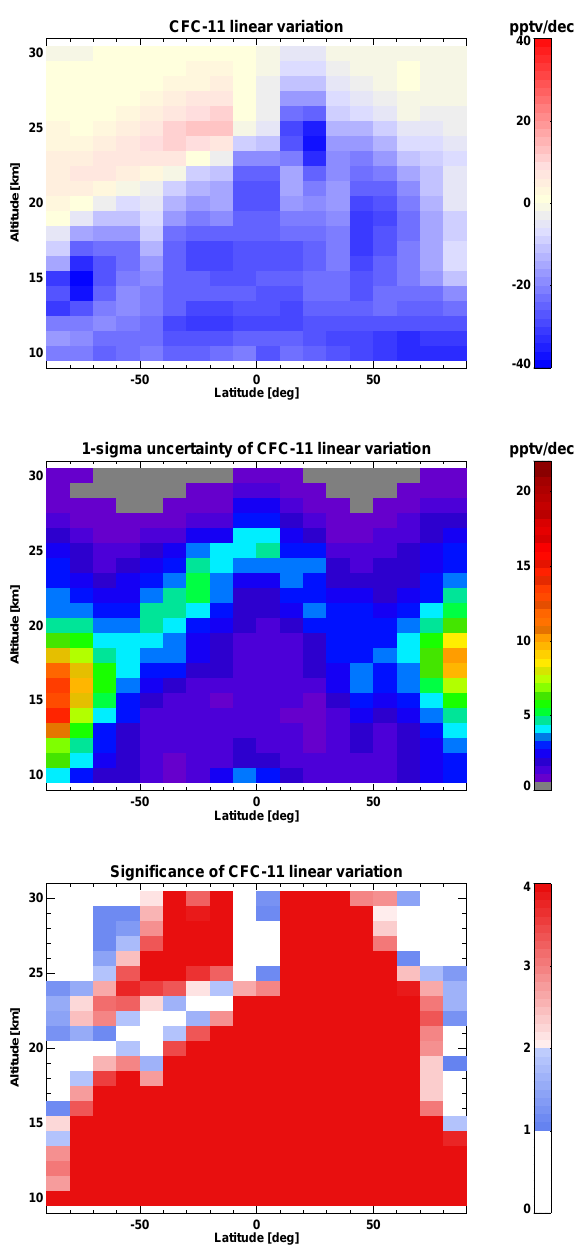
Fig. 12. CFC-11 trends over the years 2002 to 2011 as a function of altitude and latitude in pptv per decade (top); 1-sigma trend uncer- tainties (middle); and significance of the trend in terms of multiples of sigma (bottom). Numerical values are found in the Supplement.